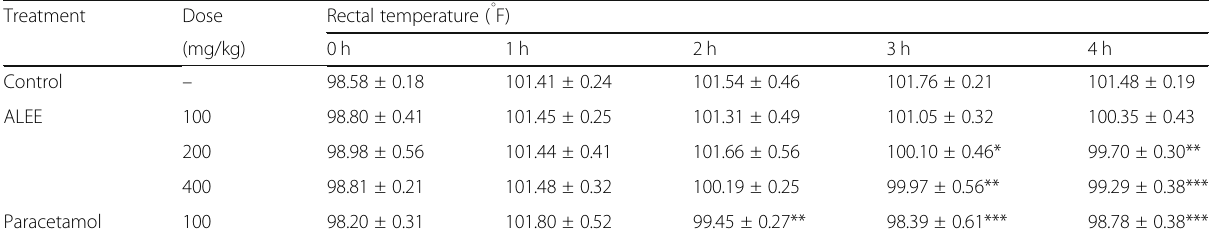
Table 5 Antipyretic effect of ALEE